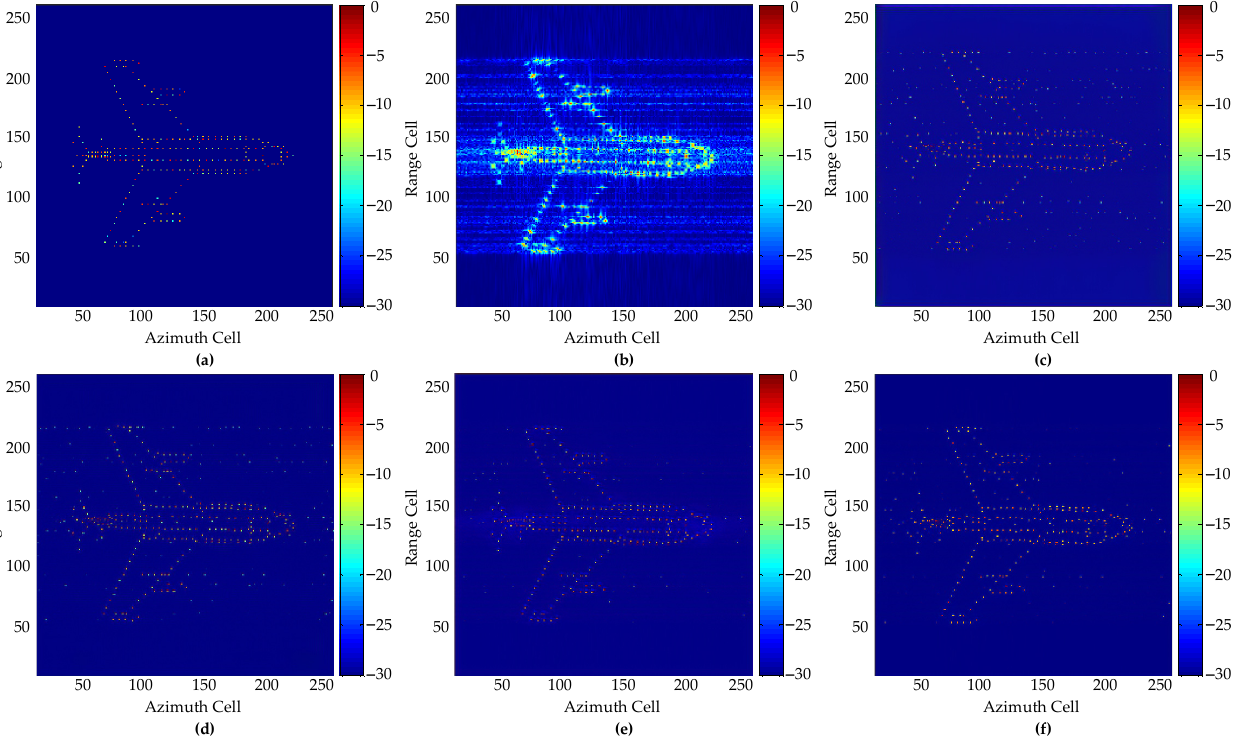
16 of 19 Table 5. Numerical performance evaluation for Yak42 at SNR = 2 dB. Method